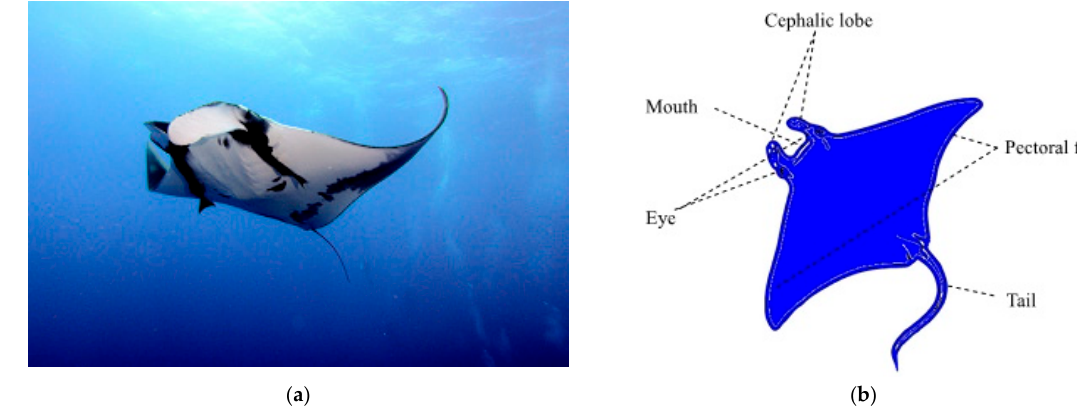
Figure 1. Manta rays and the main parts of their body: ( a ) Manta ray; ( b ) Manta rays’ physical construction.